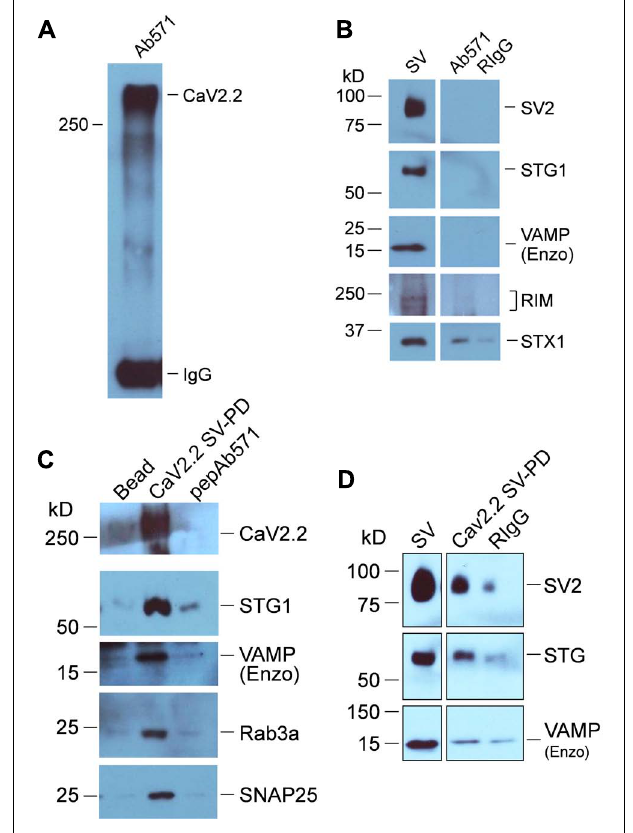
FIGURE 4 | SV-PD by synaptosome membrane CaV2.2. (A) CaV2.2 channels were captured by standard IP from synaptosome surface membrane lysate using Ab571. Note: the band for this large ∼ 250 kD protein often runs at a higher molecular weight.The IgG 50 kD band is also shown. (B) CaV2.2 IP’d by Ab571, as in (A) was tested for SV marker proteins by western blot. Most markers (SV2, STG1, andVAMP are shown) were negative except STX1 (see text). (C,D) Two examples of SV capture by CaV2.2 from separate experiments.The channel was immobilized from synaptic membrane lysate as in (A) and was then washed in detergent-free HB prior to incubation with a suspension of chick SVs (purified as above). Controls were untreated beads ( Beads ) or Ab571 pre-blocked with its immunoprecipitation peptide ( pepAb571 , N = 3) in (C) and pre-immune rabbit IgG ( RIgG ) in (D) After rinsing in HB, captured proteins were assessed byWB. Capture of SVs by only beads with pre-bound CaV2.2 ( CaV2.2 SV-PD lanes ) was indicated by the recovery of multiple protein markers.The number of experiments carried out for SV protein Cav2.2 SV-PD was N STG1 = 10; N SV2 = 6; N RIM = 6.